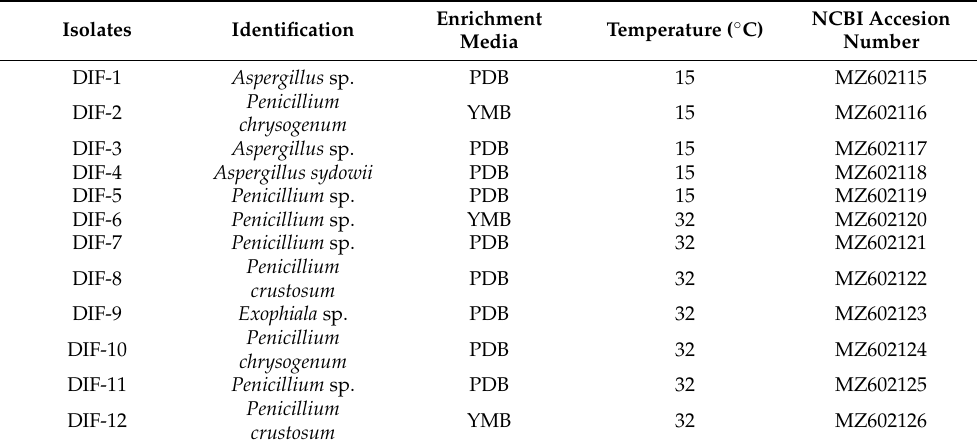
Table 4. Fungal strains isolated in the sediment. Culture media and temperature of